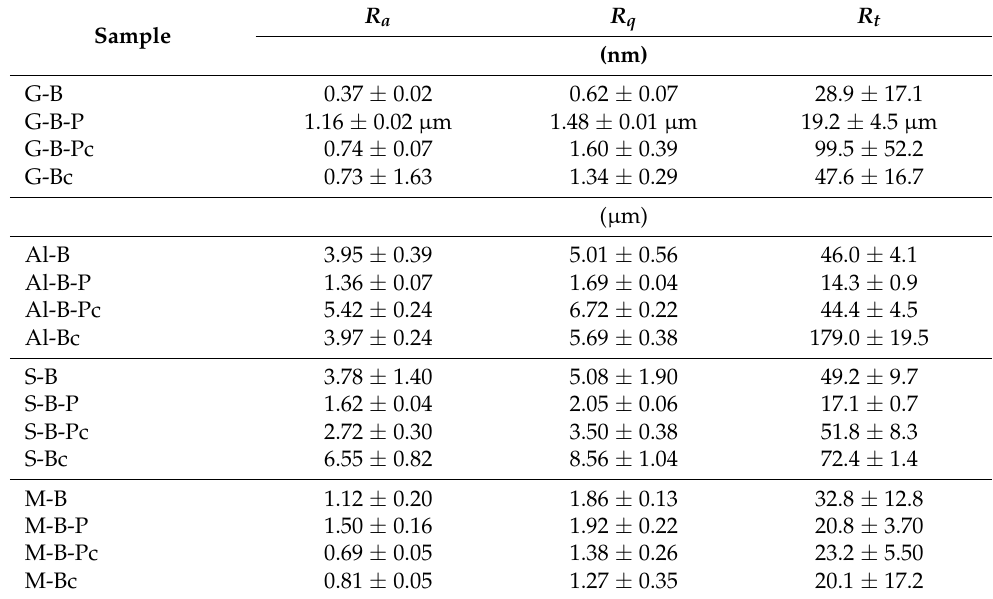
Table 4. Roughness parameters of the sensitive bare surfaces: glass (G-B), aluminum alloy (Al-B), stone (S-B), marble (M-B), painted (B-P), after removal of paint coating (B-Pc) and cleaning the bare surface with nanoemulsion